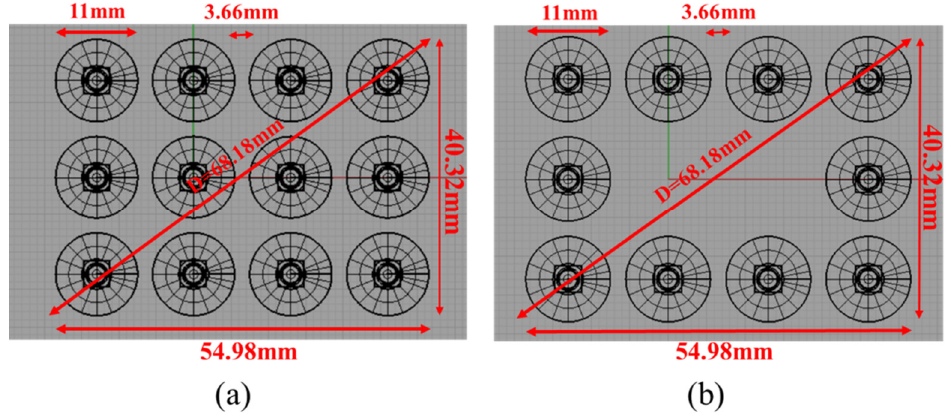
Figure 5. ( a ) Solid and ( b ) hollow LED-array luminaires.